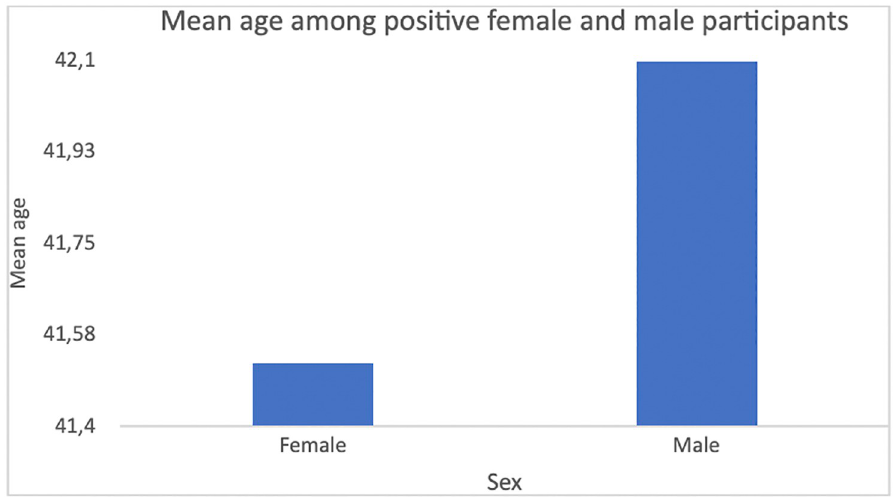
Fig 5. Mean age among positive female and male participants. The mean age of all individuals who tested positive was 43.21 ± 14.91. Mean age did not differ significantly between men (43.51 ± 14.99) and women (42.86 ± 14.82) who tested positive (t test = 1.589; p =